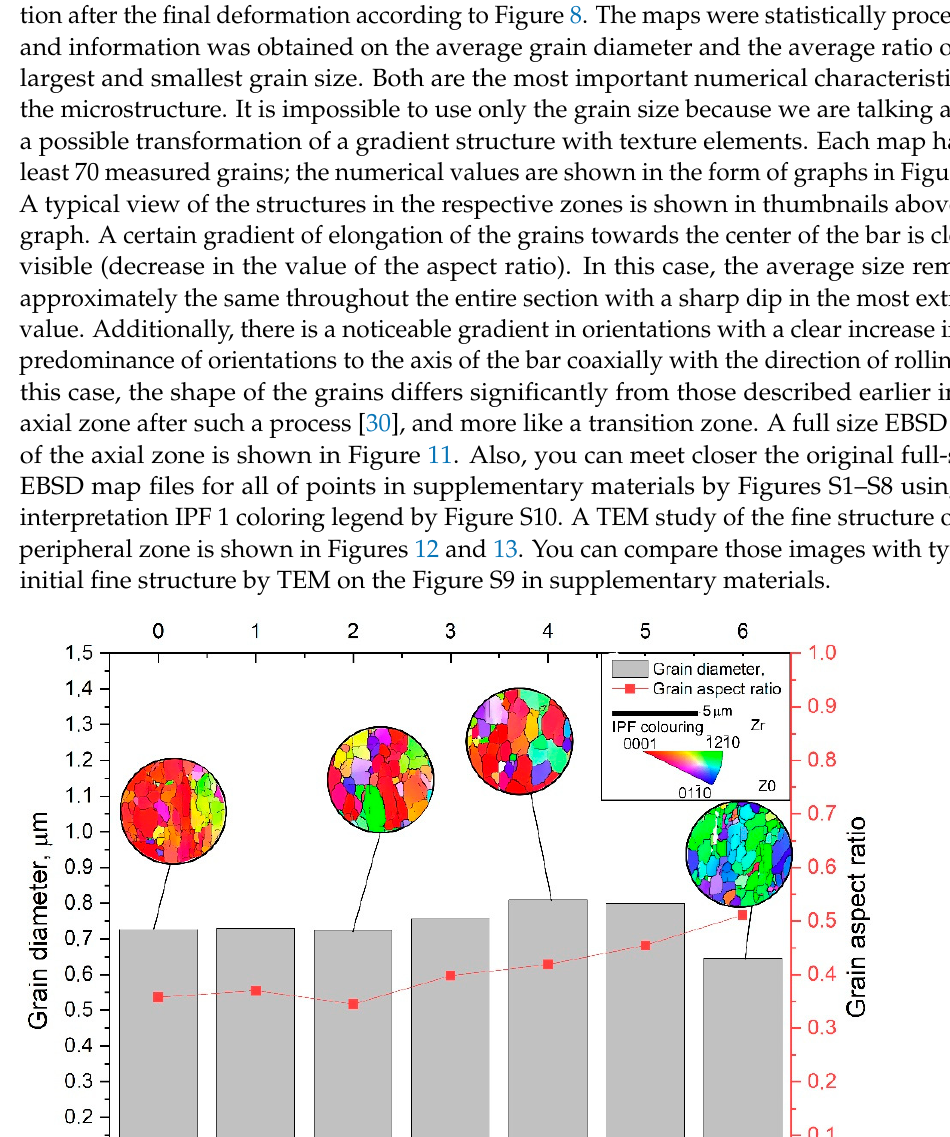
Figure 11. The central (axial) zone of the final rolled sample EBSD map.